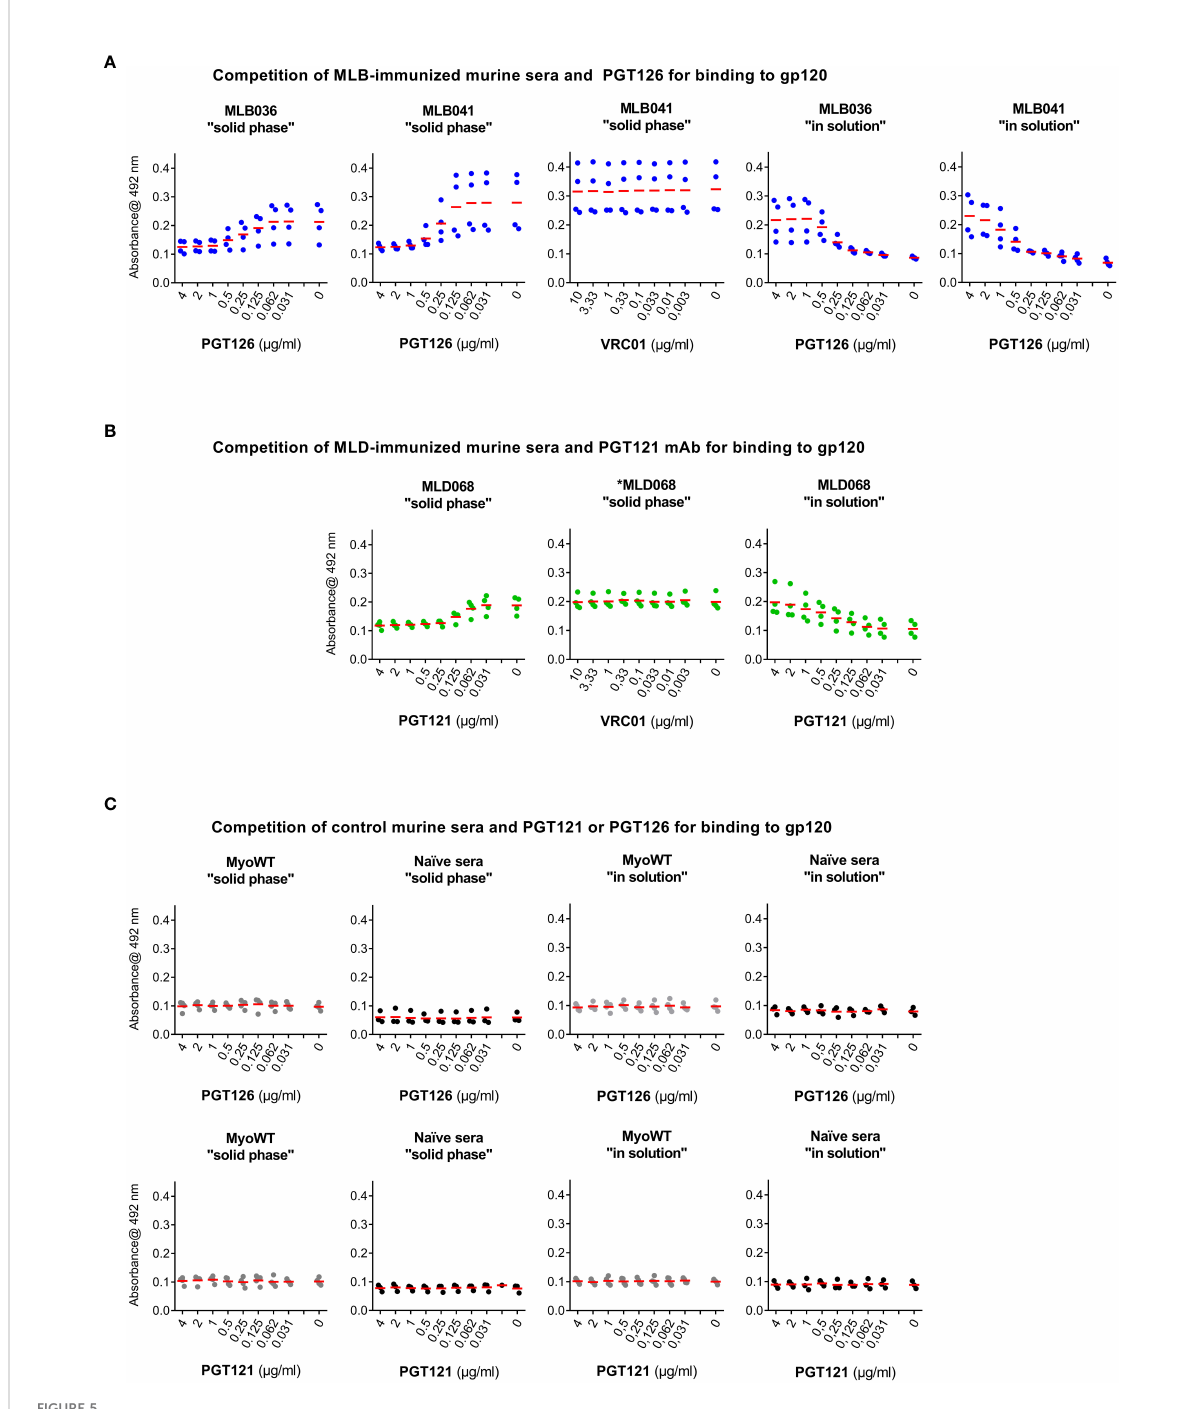
FIGURE 5 PGT126 and PGT121 compete with sera from MLB- or MLD-immunized mice for binding to HIV-1 multimeric gp120. Binding of sera from (A) MLB036-, MLB041- or (B) MLD068-immunized mice to recombinant multimerizing HIV-1 consensus B gp120 protein was inhibited by increasing concentrations of PGT126 or PGT121. As a control, irrelevant VRC01 anti-HIV-1 mAb was used. VRC01 mAb reactivity with used multimerizing consensus B gp120 was reported earlier (29). The competition was performed either by addition of the hyperimmune serum to the gp120-coated well together with individual mAb (at indicated dilution), designated as a “ solid phase ” competition or the serum was preincubated with gp120 and individually diluted mAb and after incubation the mixture was added to gp120-coated well, designated as “ in solution ” competition. (C) Naïve sera or sera from MyoWT-immunized mice were used as controls tested both in “ solid phase ” and “ in solution ” conditions. All tested mouse sera were diluted (1:200) and their binding was visualized using HRP-conjugated rabbit anti-mouse IgG mAb. The mean values are indicated by horizontal